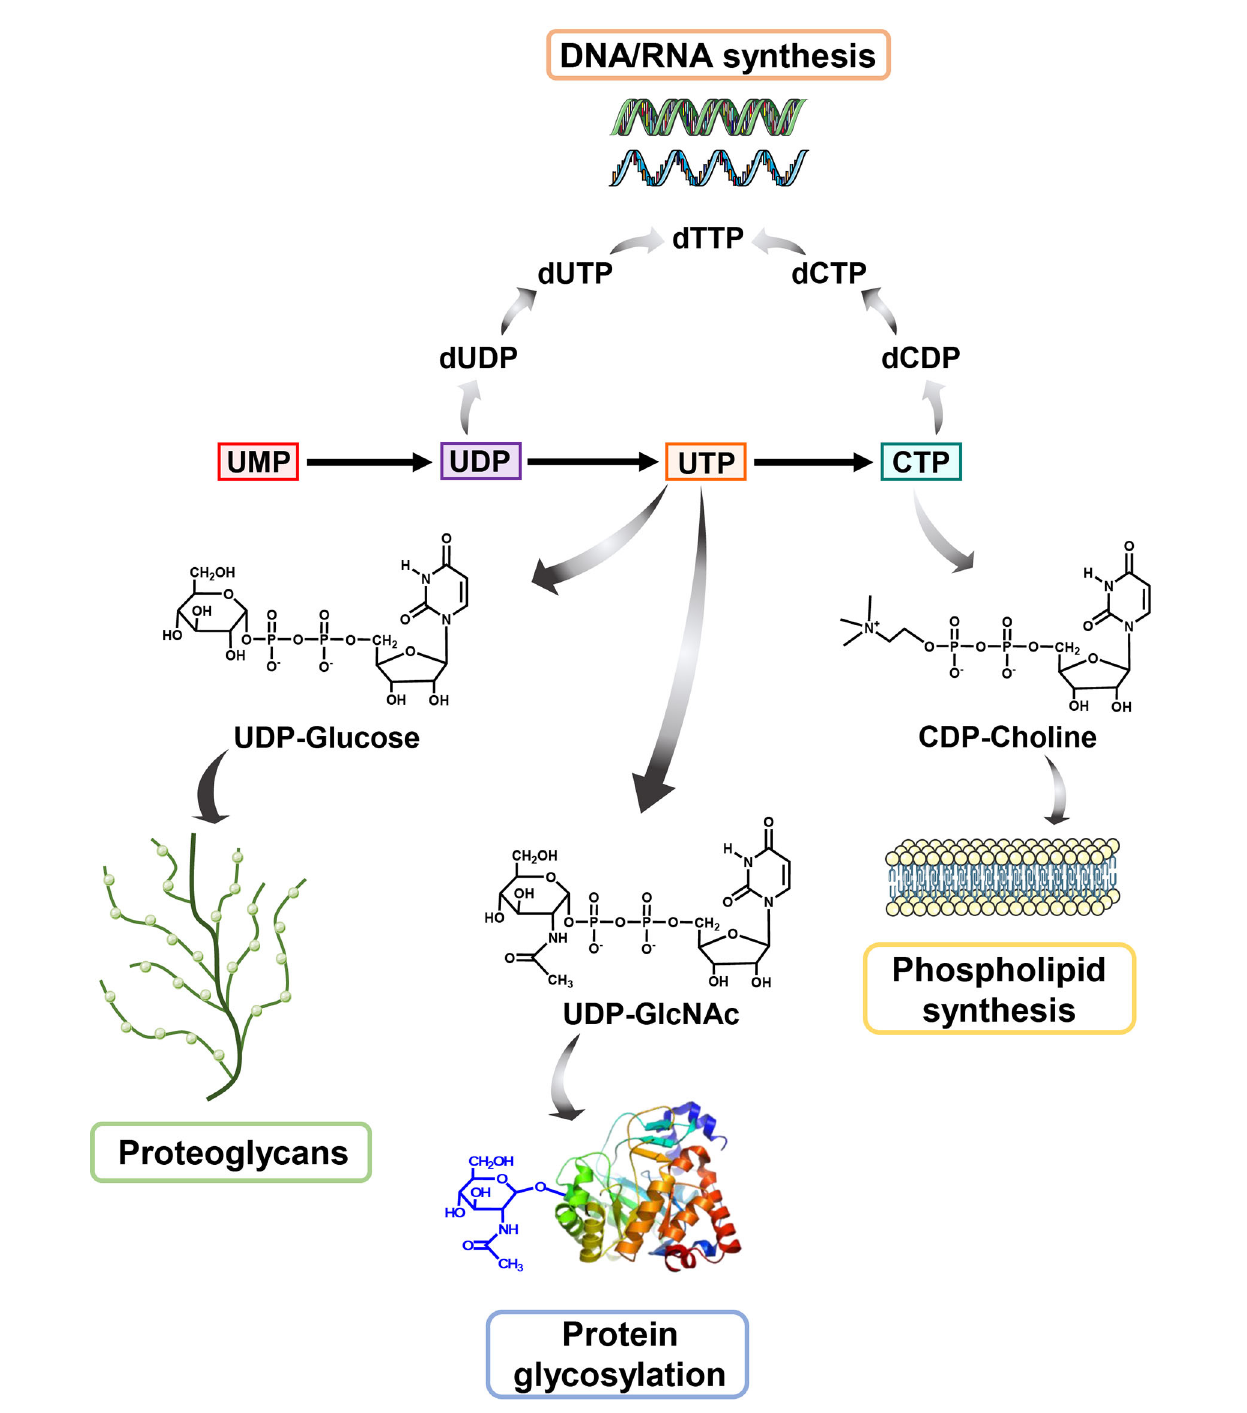
FIGURE 2 | The biological role of pyrimidine In addition to serving as an indispensable substrate for DNA and RNA biosynthesis, pyrimidine also participates in many other cellular metabolisms. UDP-GlcNAc, derived from UTP, is a pivotal metabolic used in O-GlcNAc modi fi cation of protein while UDP-glucose is used to synthesis proteoglycans. Besides, CTP could be converted to CDP-Choline for participating in producing phosphatidylcholine (PC), a primary component of